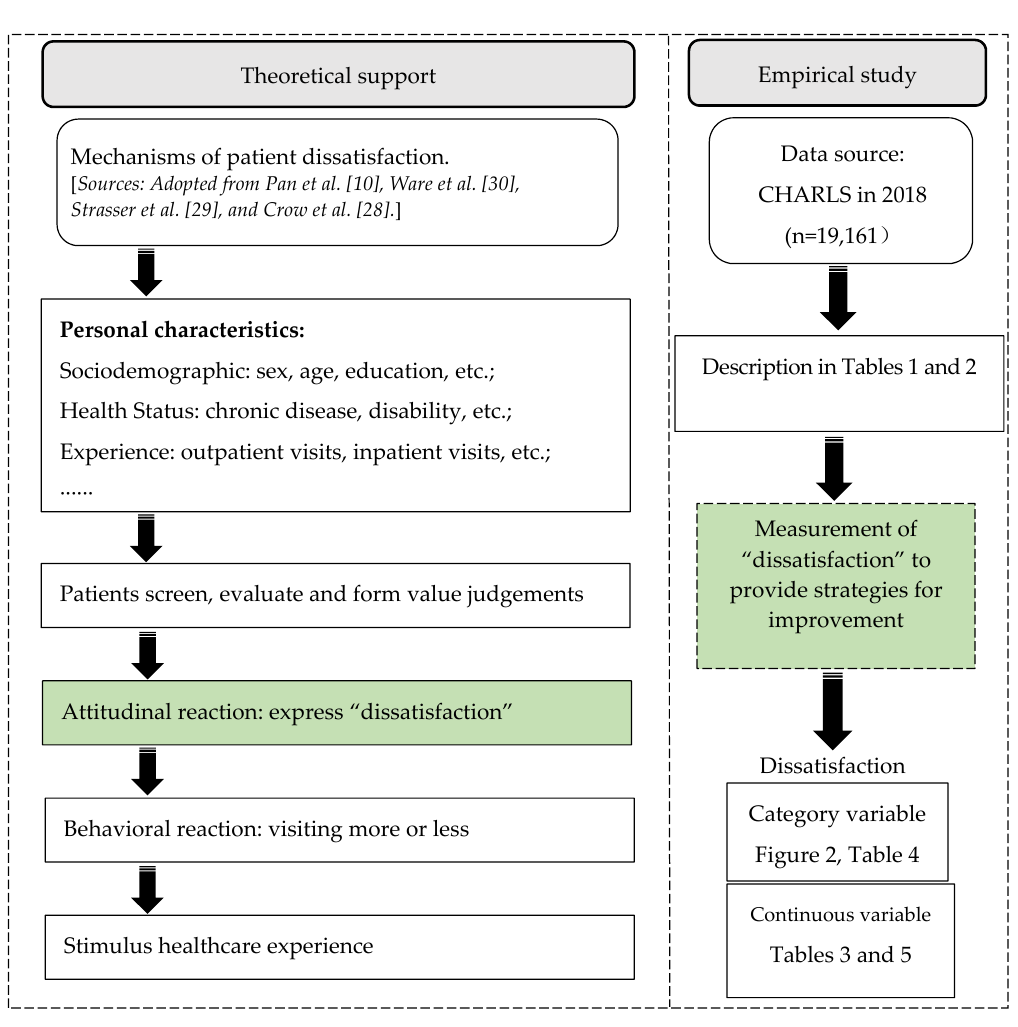
Figure 1. Flowchart of the study.